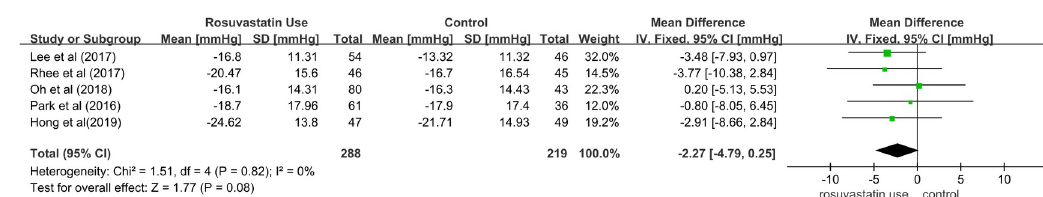
Fig 3. Pooled mean differences for the outcomes of changes in systolic blood pressure in patients with hypertension receiving rosuvastatin therapy vs. placebo or standard care.